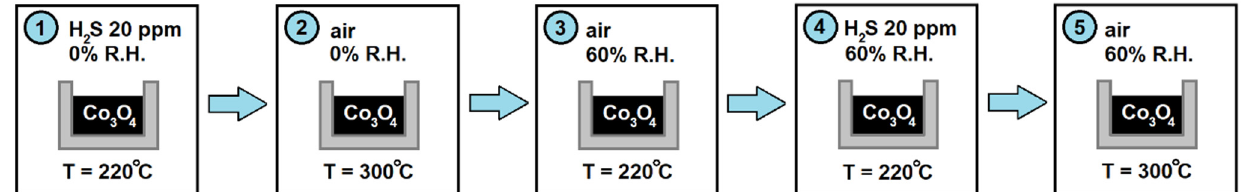
Figure 3. Diffuse-reflectance infrared Fourier-transform spectroscopy (DRIFTS) experimental scheme for Co 3 O 4 .